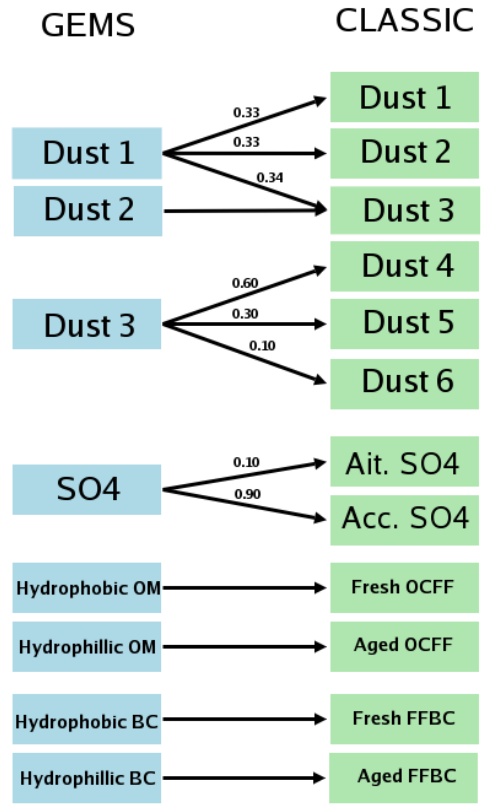
Fig. 1. Schematic of the procedure used to map GEMS aerosol species to CLASSIC aerosol